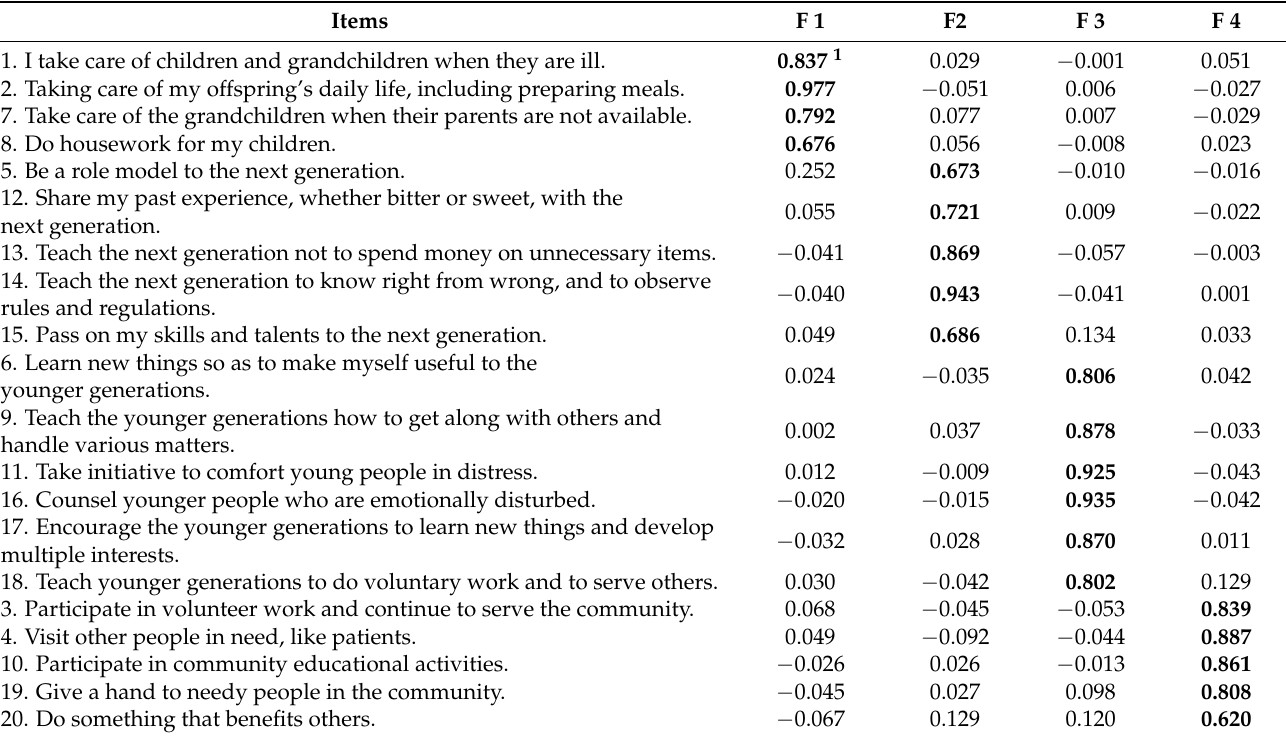
Table 1. Rotated factor loadings matrix from EFA (Subsample A, random half; n = 506). Items F